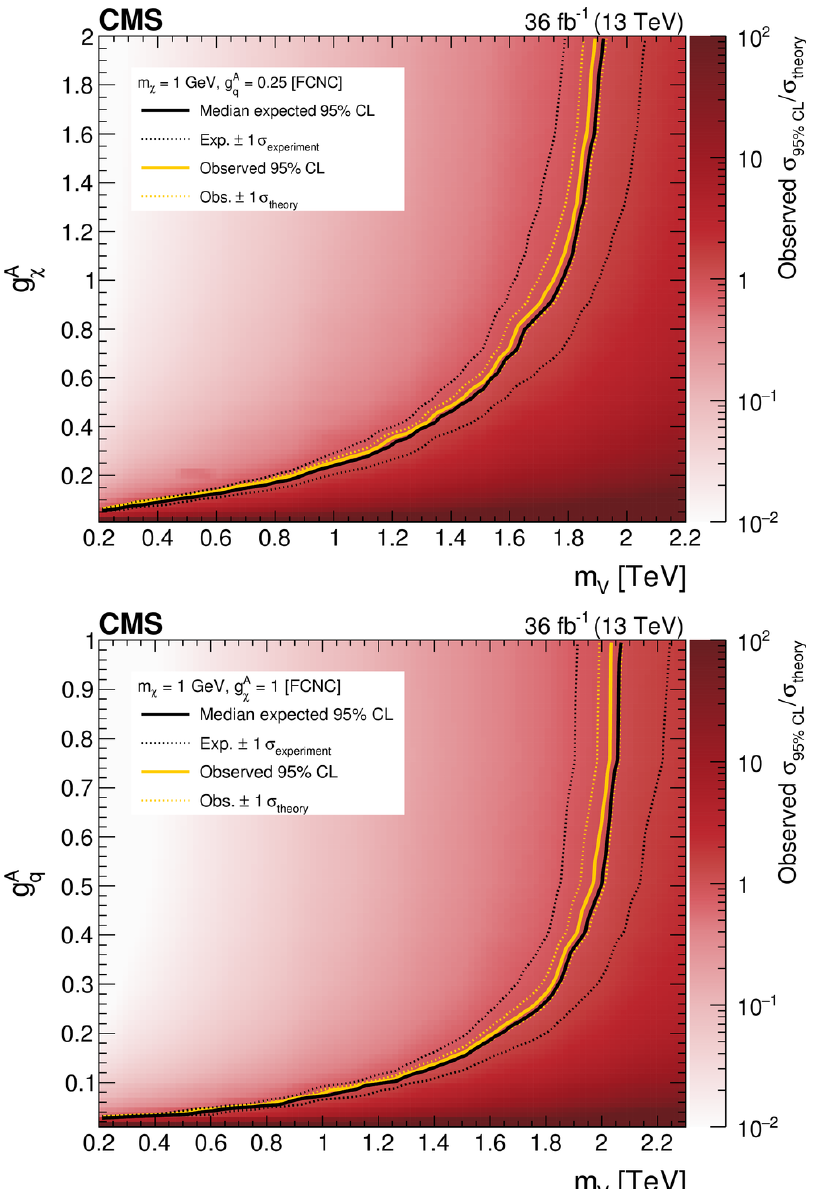
Figure 12 . Results for the FCNC interpretation presented in the two-dimensional plane spanned by the mediator mass and the coupling between the mediator and DM (upper) or quarks (lower). The mediator is assumed to have purely axial couplings. The observed exclusion range (gold solid line) is shown. The gold dashed lines show the cases in which the predicted cross section is shifted by the assigned theoretical uncertainty. The expected exclusion range is indicated by a black solid line, demonstrating the search sensitivity of the analysis. The experimental uncertainties are shown in black dashed lines.